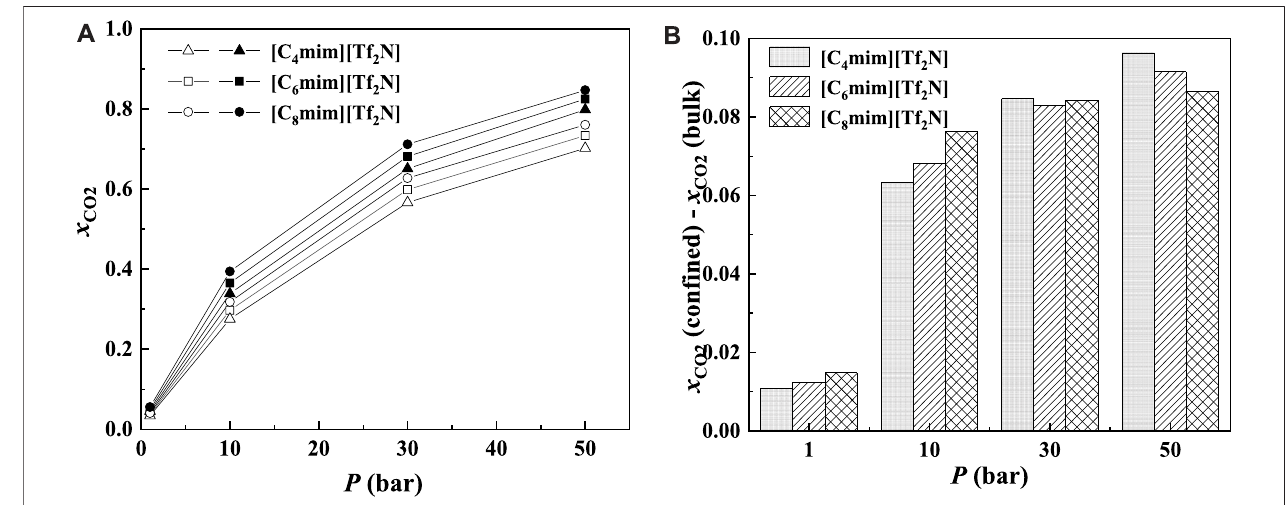
FIGURE 14 | Calculated CO 2 solubility (A) and additional solubilities (B) of ILs con fi ned in 25 Å slit-shaped pore at 298.15 K and different pressures. (A) Solid symbols, data for con fi ned ILs; open symbols, data for bulk ILs.